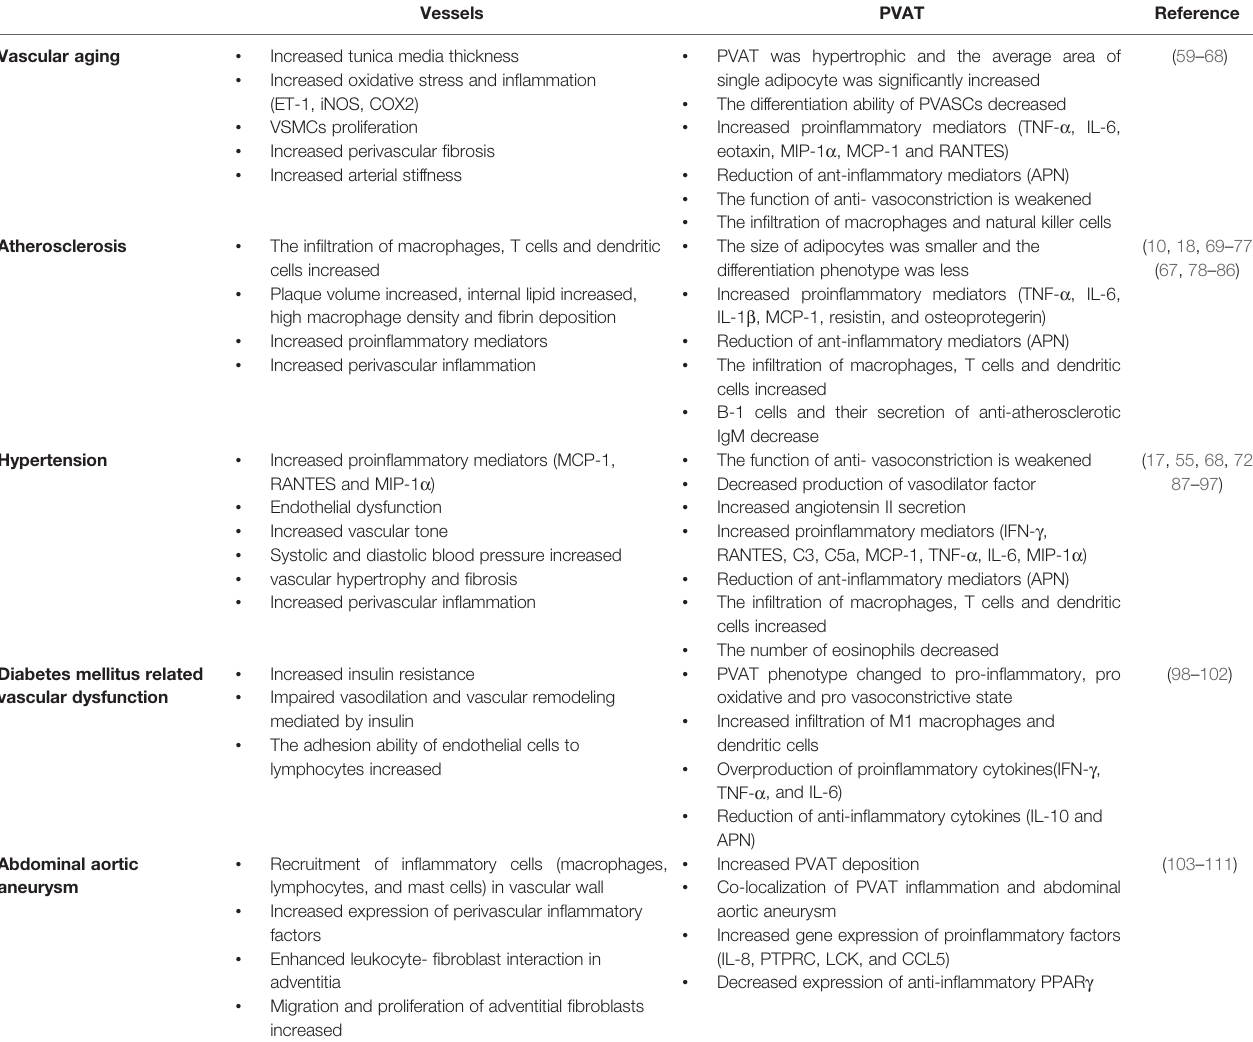
TABLE 1 | Central roles of PVAT in fl ammation in vascular diseases. Vessels